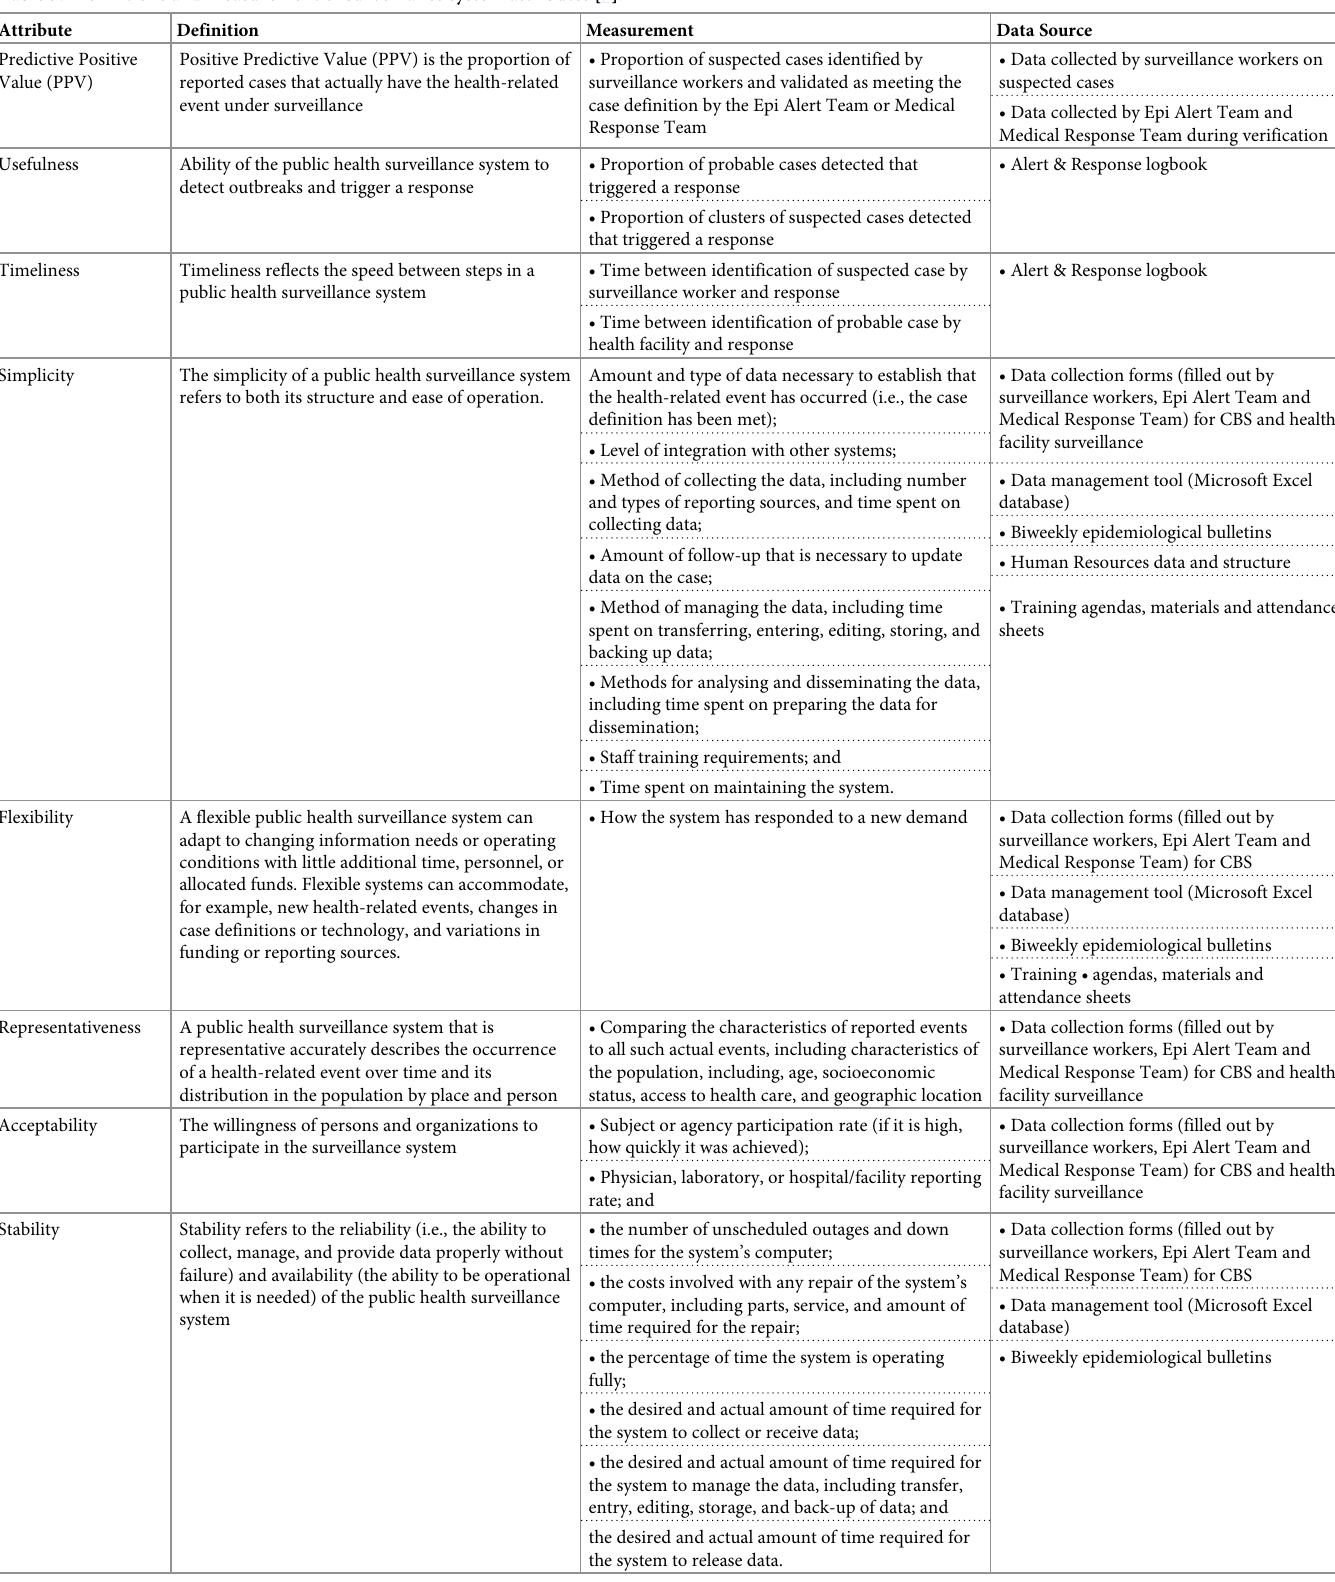
Table 3. Definitions and measurement of surveillance system attributes